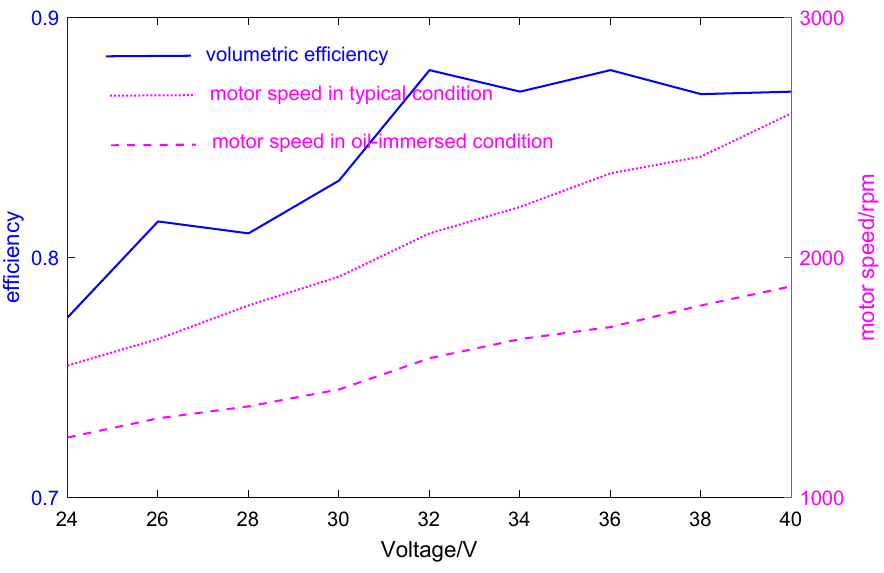
Figure 10. The influence of oil on motor speed and speed on volumetric efficiency.